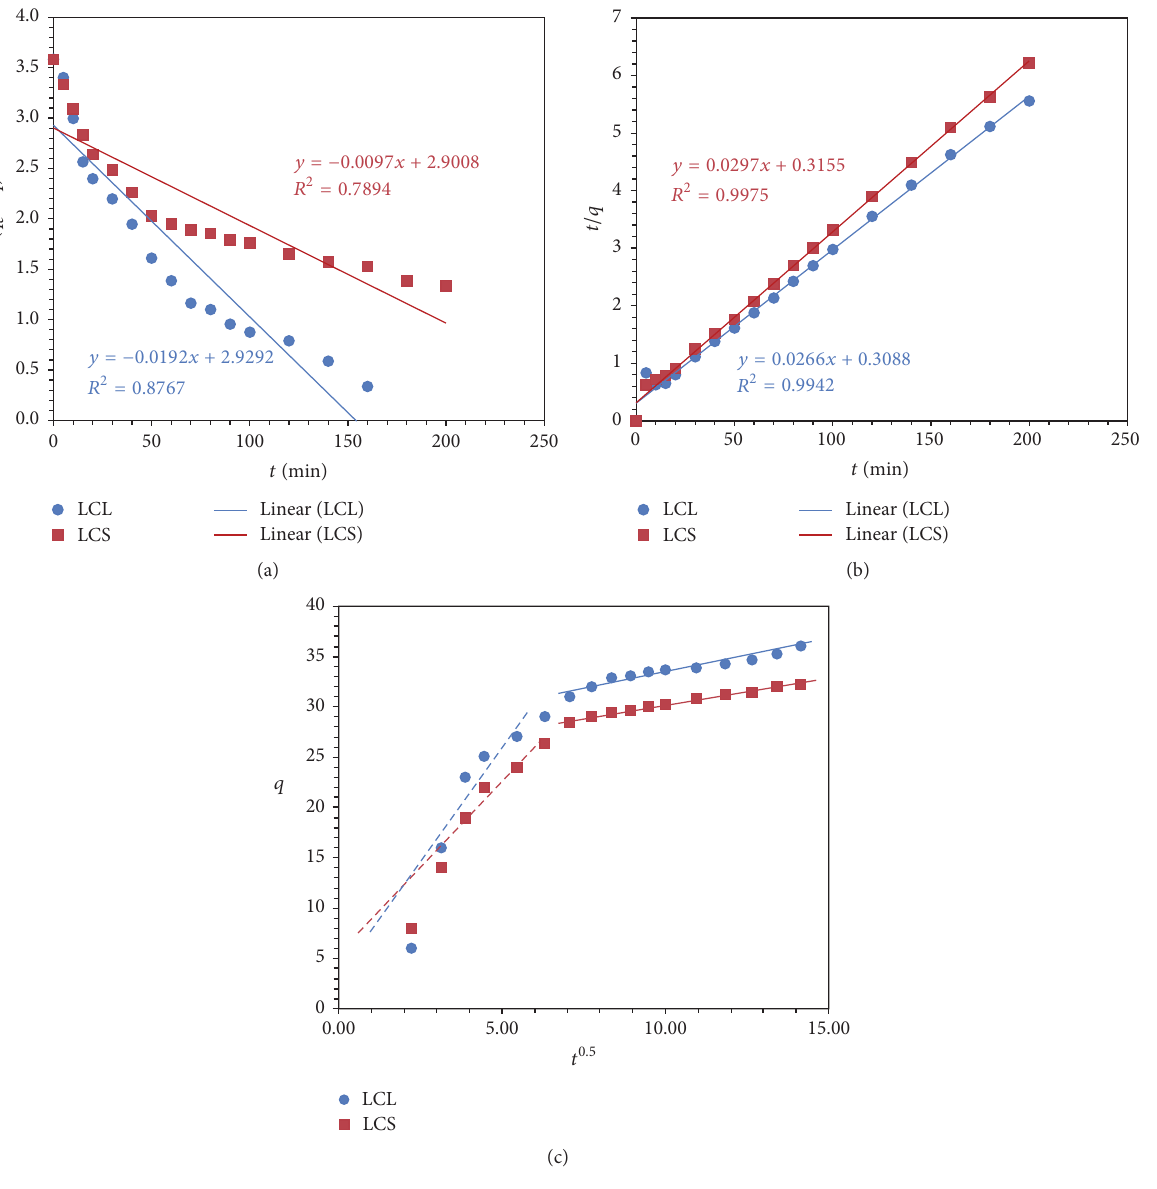
Figure 5: Kinetic analysis of adsorption capacity as a function of time (min −1 ), using three different models: (a) pseudo-first-order, (b) pseudo-second-order, and (c) intraparticle diffusion model ( 𝑇 = 25 ∘